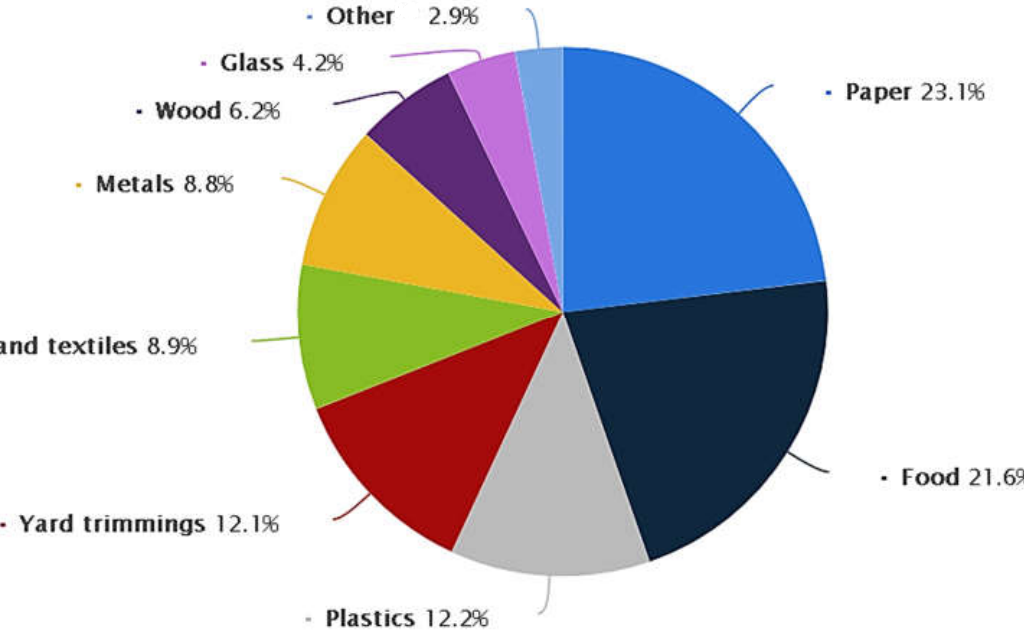
Figure 1. Distribution of MSW stream produced in the U.S in 2018. Adapted from [7].